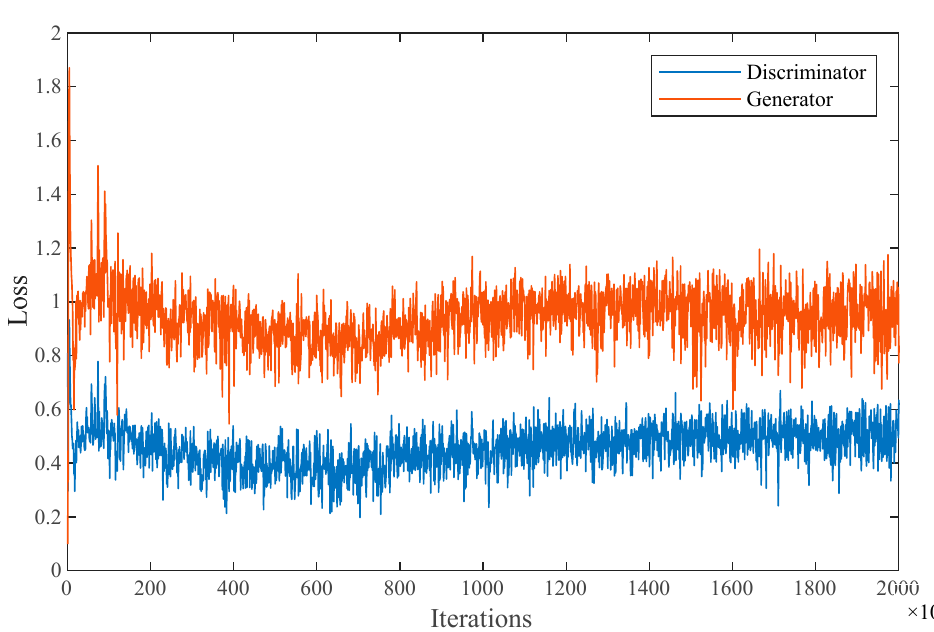
Figure 11. Loss of generator and discriminator networks.